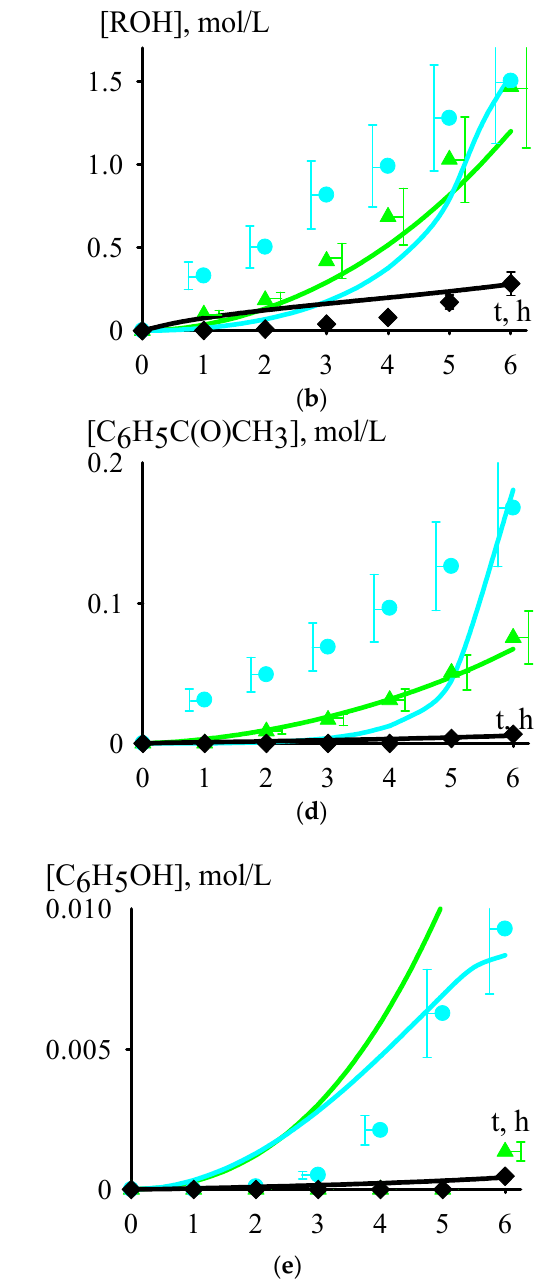
Figure 1. The dependencies of the component concentrations of the reaction mixture in cumene oxidation versus time: dots are the experimental data, and lines are the calculation by the model; ( a ) ROOH; ( b ) ROH; ( c ) C 6 H 5 C(CH 3 ) = CH 2 ; ( d ) C 6 H 5 C(O)CH 3 ; ( e ) C 6 H 5 OH.